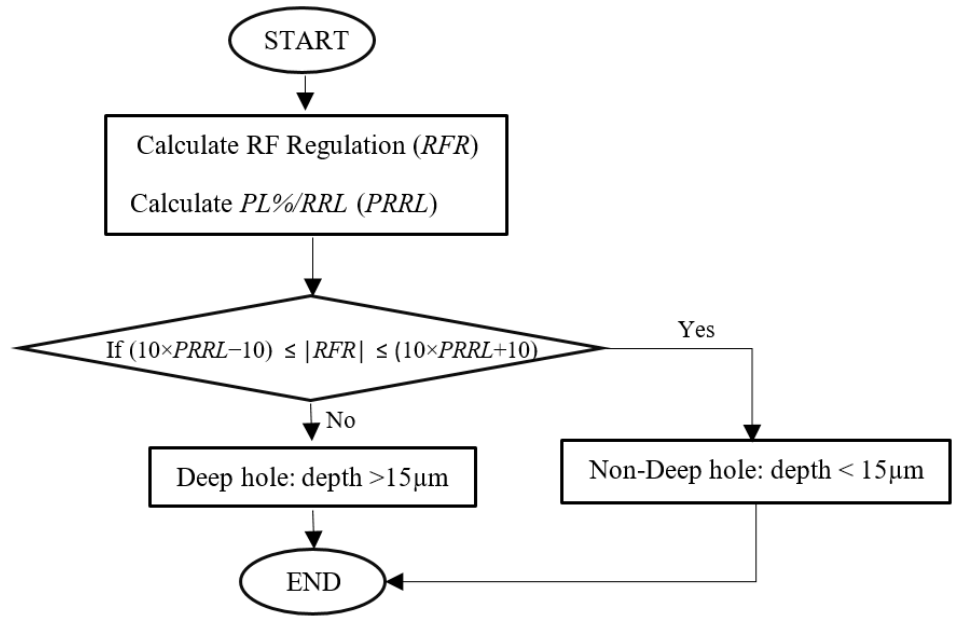
Figure 11. Flowchart of the in-process diagnostic of the depth of ablation formation using the received RF and laser properties.